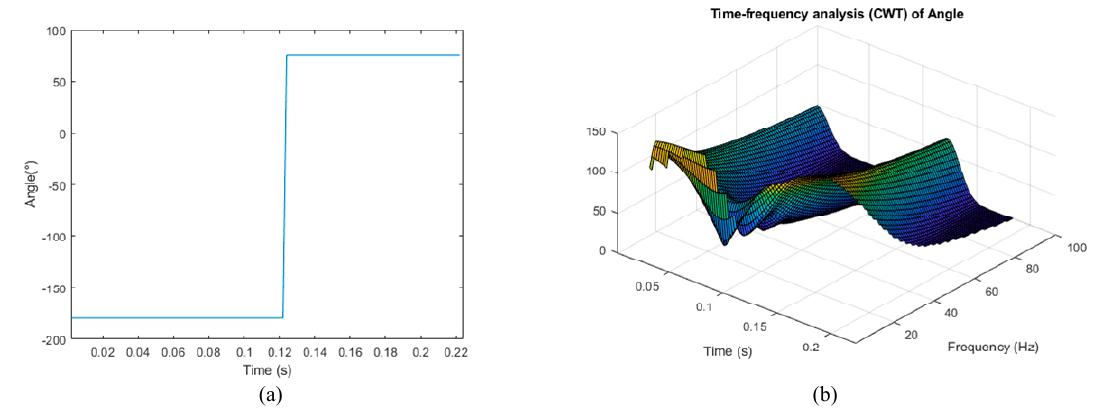
Figure 1. Angle signal when fault occurs. ( a ) Before CWT processing; ( b ) after CWT processing.